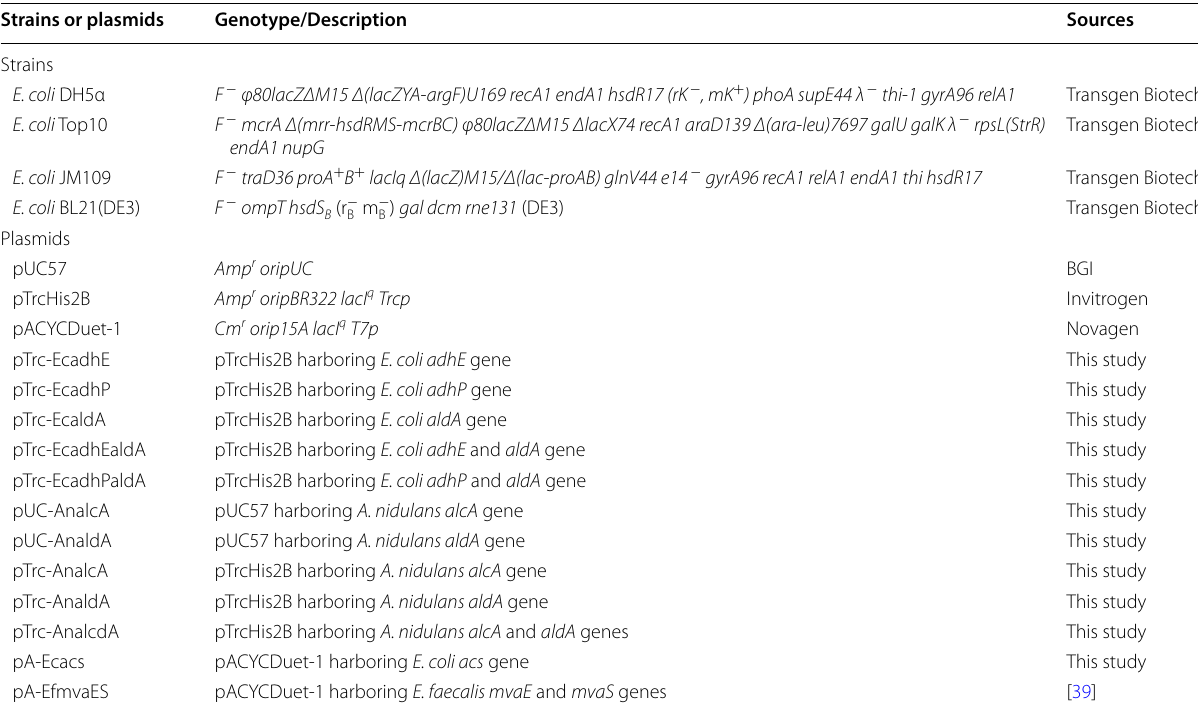
Table 2 Strains and plasmids used in this study Strains or